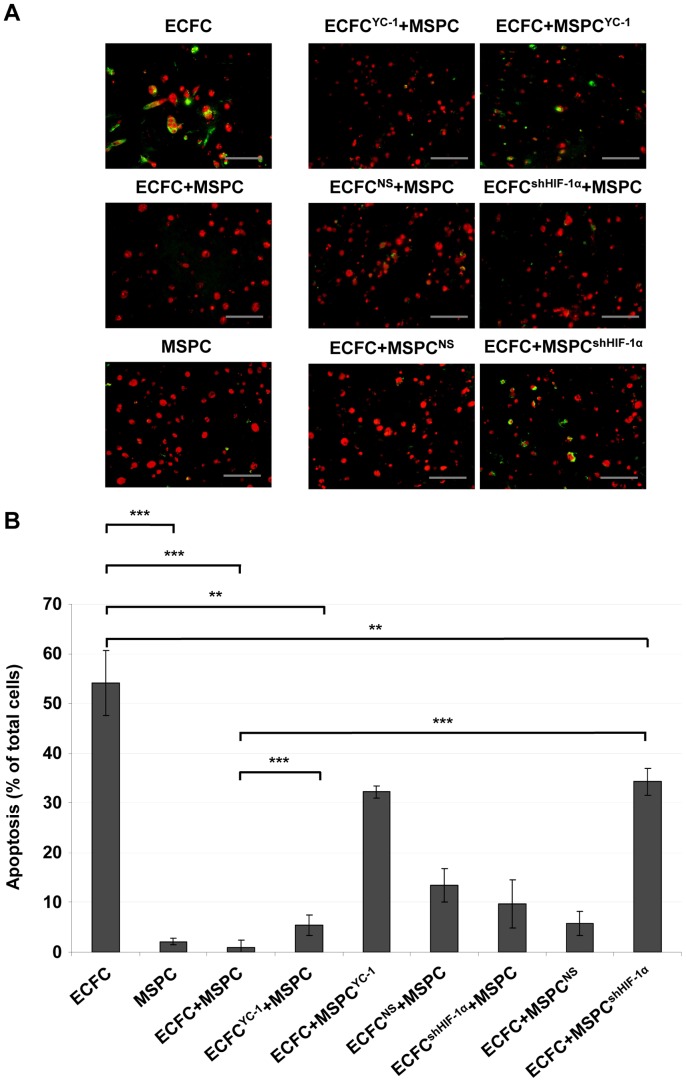
HIF-competent MSPCs are required to avoid premature ECFC apoptosis in vivo.(A) Apoptosis assay using TdT-mediated dUTP nick end labeling (TUNEL) of ECFC-only or MSPC-only transplants and treated or untreated ECFC+MSPC co-transplants, as indicated above each photograph. All plugs were explanted 24 h after implantation in vivo. DNA strand breaks of apoptotic cells were detected by a TUNEL assay kit (Promega) and nuclei were counterstained with propidium iodide (PI, red). Green fluorescence is due to FITC-labeled nucleotide binding to DNA strand breaks of apoptotic cells. Representative pictures from one experiment are shown (scale bar 100 µm, from at least three different donors performed per transplantation type as specified in the legends to Figures 3 and 4). (B) Apoptotic cells depicted as percentage of total cells ± SD with groups corresponding to the representative pictures in (A); five high power fields 200x; ***p<0.0001, **p<0.01).